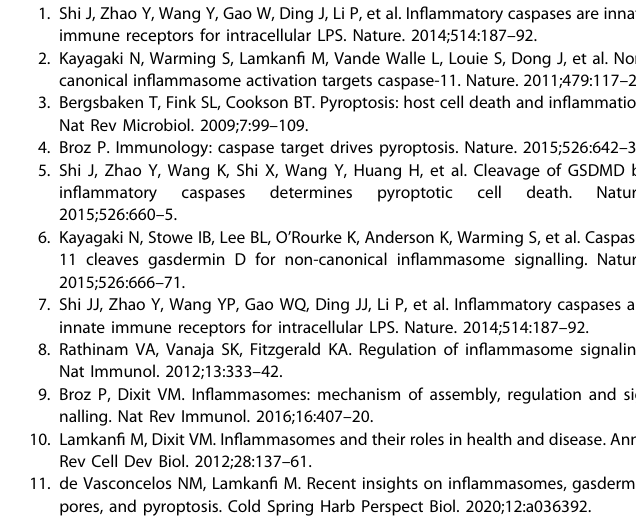
Fig. 8 Diagram of SYVN1 regulating GSDMD-mediated pyroptosis. Working model for SYVN1 promoting the activation of canonical and noncanonical in fl ammasomes-mediated pyroptosis. SYVN1 binds to GSDMD, promotes the K27-linked polyubiquitination of K203 and K204 lysine residues on GSDMD, resulting in the increasement of